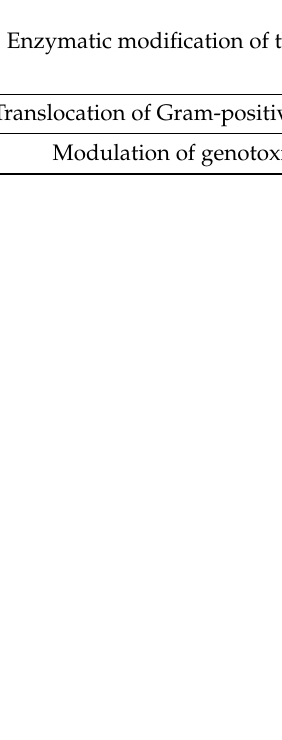
Table 1. Summary of the potential effects of gut microbiota on anticancer agents used in clinical hematology. Mechanism Outcome Involved Drug (s) Cladribine, gemcitabine, doxorubicin, Decreased levels Idarubicin, etoposide, mitoxantrone [99] Enzymatic modification of the drugs Increased activity Fludarabine, 6-Mercaptopurine [99] Translocation of Gram-positive bacteria Generation of Th17 and Th1 lymphocytes Cyclophosphamide [74] Modulation of genotoxicity Reduction of DNA damage and apoptosis Oxaliplatin, cisplatin